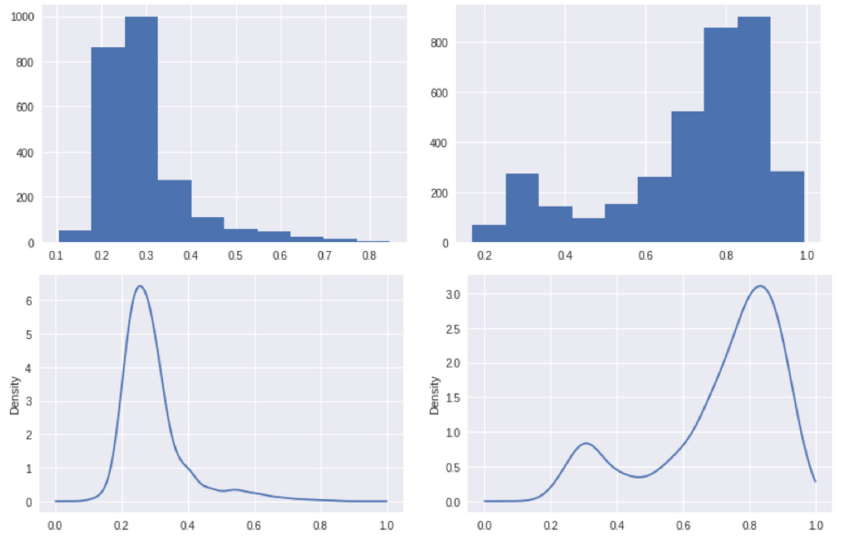
Figure 12. The histograms ( top row) and PDFs ( bottom row) for Non-Defect class ( left column) and Defect class ( right column) of NEU steel surface defect dataset [26].